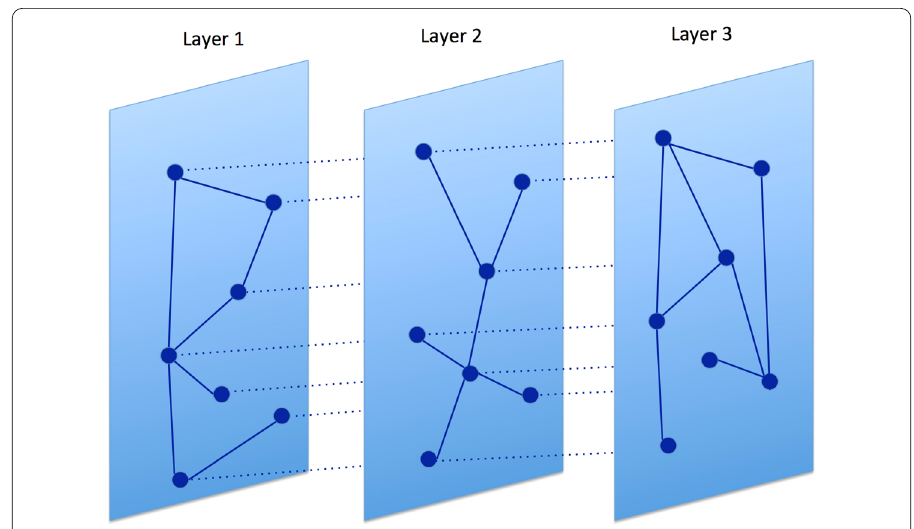
Figure 1 Example of a multiplex configuration. A three layer multiplex network showing the inter-layer and intra-layer correspondences between different nodes